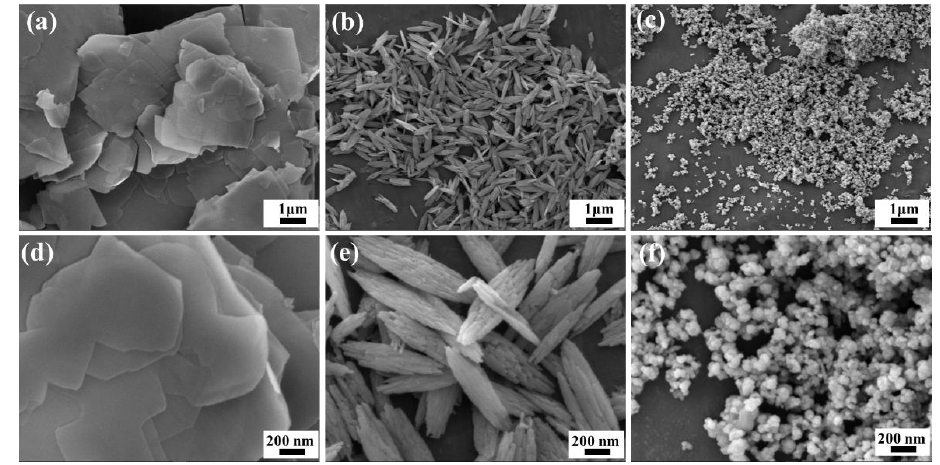
Figure 2. SEM images of precursors. ( a , d ): F-precursors; ( b , e ): S-precursors; ( c , f ): N-precursors.